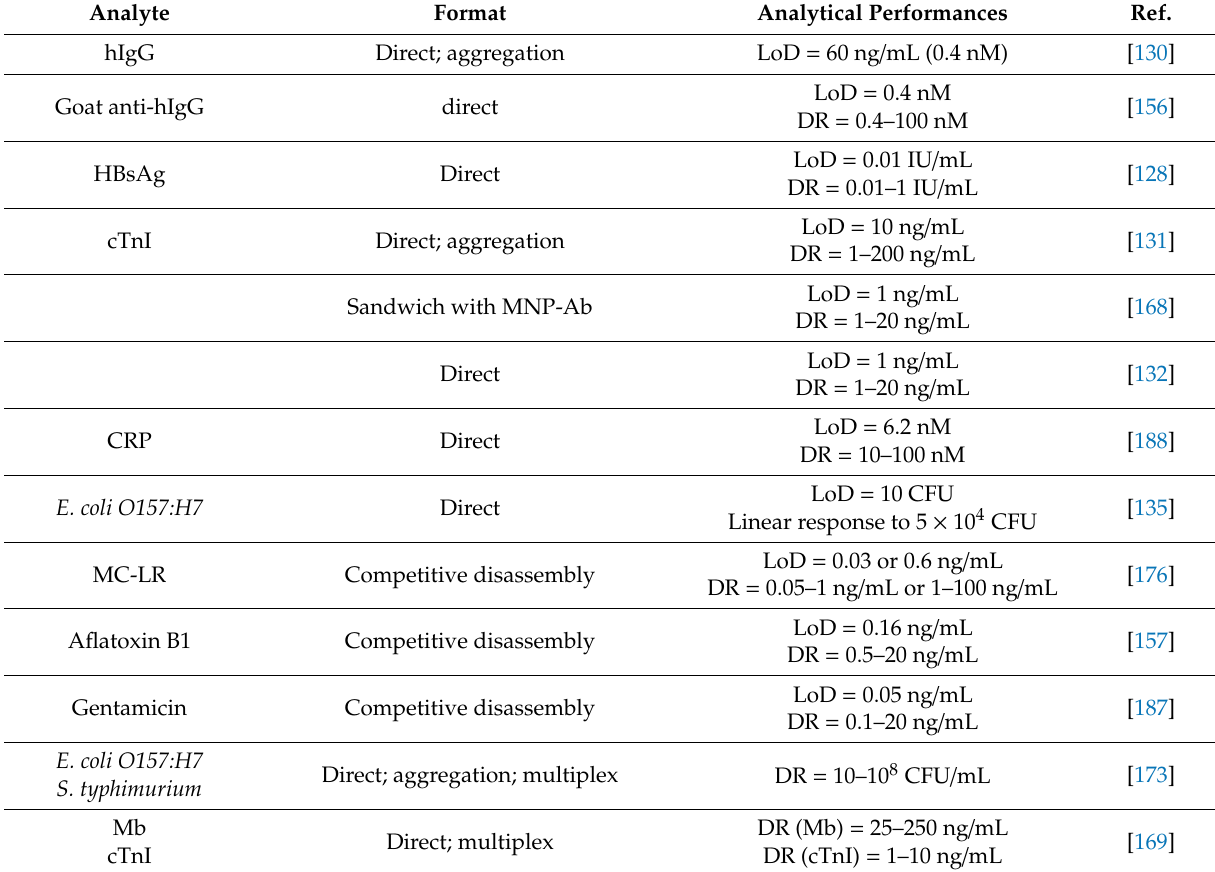
Table 4. Strategies, analytes, and analytical performances for solution-phase based